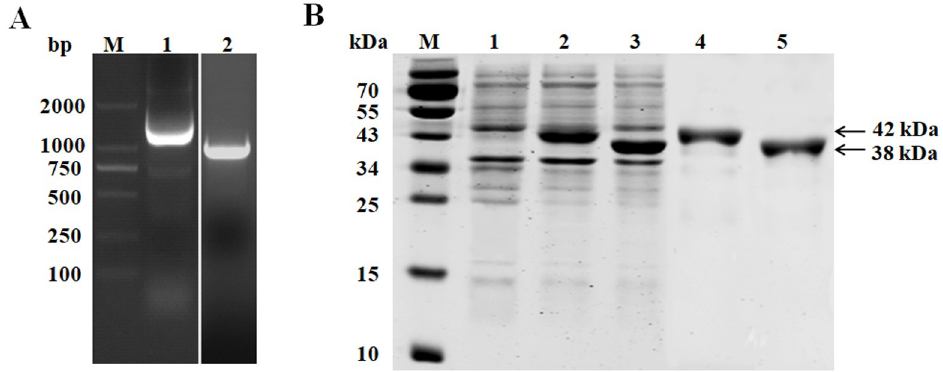
Fig 1. Cloning and expression of the M . gallisepticum pdhA and pdhB genes. (A) Results of PCR amplification. Lane M: DNA marker; Lane 1: pdhA gene of M . gallisepticum ; Lane 2: pdhB gene of M . gallisepticum . (B) SDS-PAGE of rPDHA and rPDHB. Lane M: Prestained protein marker; Lane 1: E . coli BL21 (DE3) transformed with pET-28a (+) induced by IPTG (negative control); Lane 2: E . coli BL21 (DE3) containing recombinant pET28a-PDHA induced by IPTG; Lane 3: E . coli BL21 (DE3) containing recombinant pET28a-PDHB induced by IPTG; Lane 4: Purified rPDHA protein (42 kDa); Lane 5: Purified rPDHB protein (38 kDa).